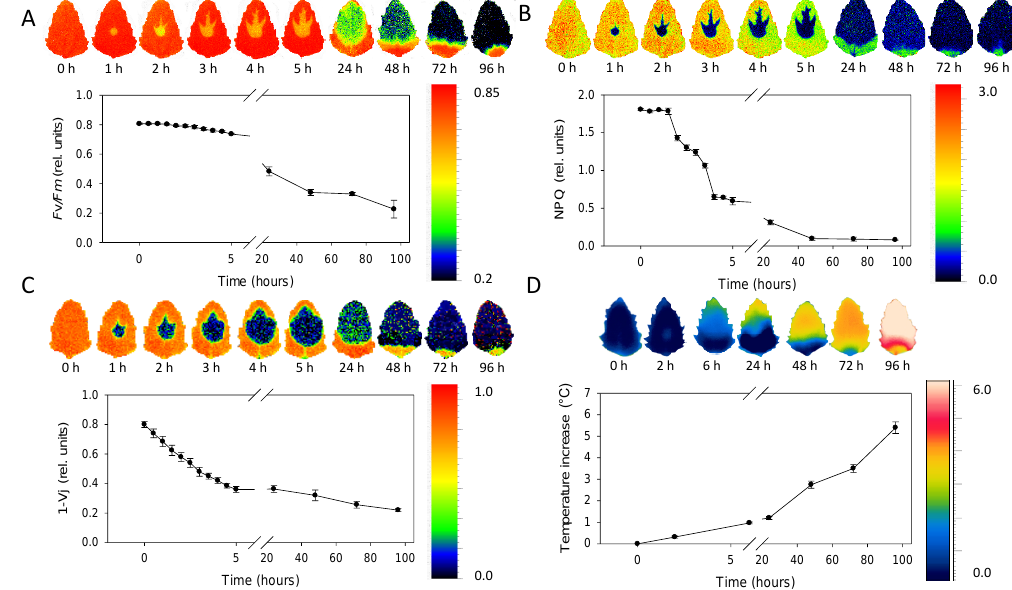
Figure 5. Sequence of chlorophyll fluorescence and thermal imaging of leaves in the span 0–96 h after application. ( A ) The maximum quantum efficiency of PSII ( F v/ F m). ( B ) Non-photochemical